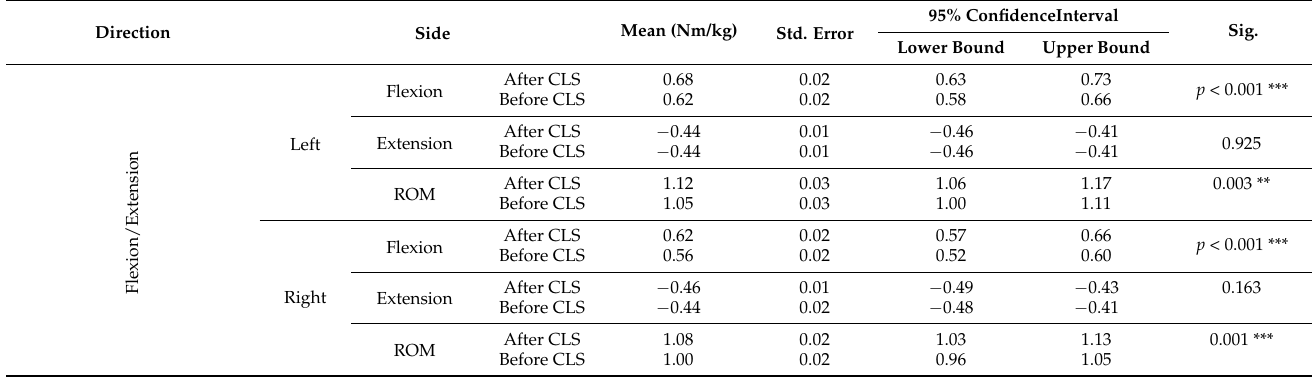
Table 10. Knee Joint Moment in Flexion/Extension, Adduction/Abduction, and Internal/External Rotation